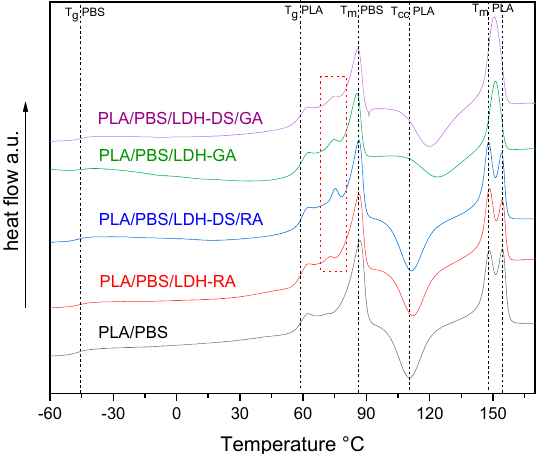
Figure 10. DSC curves (2 nd heating) of PLA/PBS blend and its composites. The dashed black lines indicate the fundamental transitions of the PLA/PBS blend, while the dashed red square indicates a new endothermic transition not present in the PLA/PBS blend.